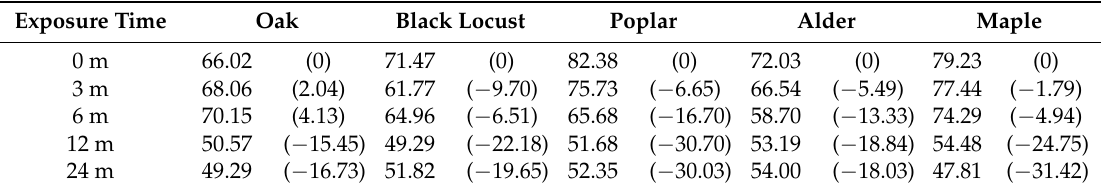
Table 4. Exposure time-dependence of L * value (lightness differences ∆ L * are in brackets). The data represent mean values. Exposure Time